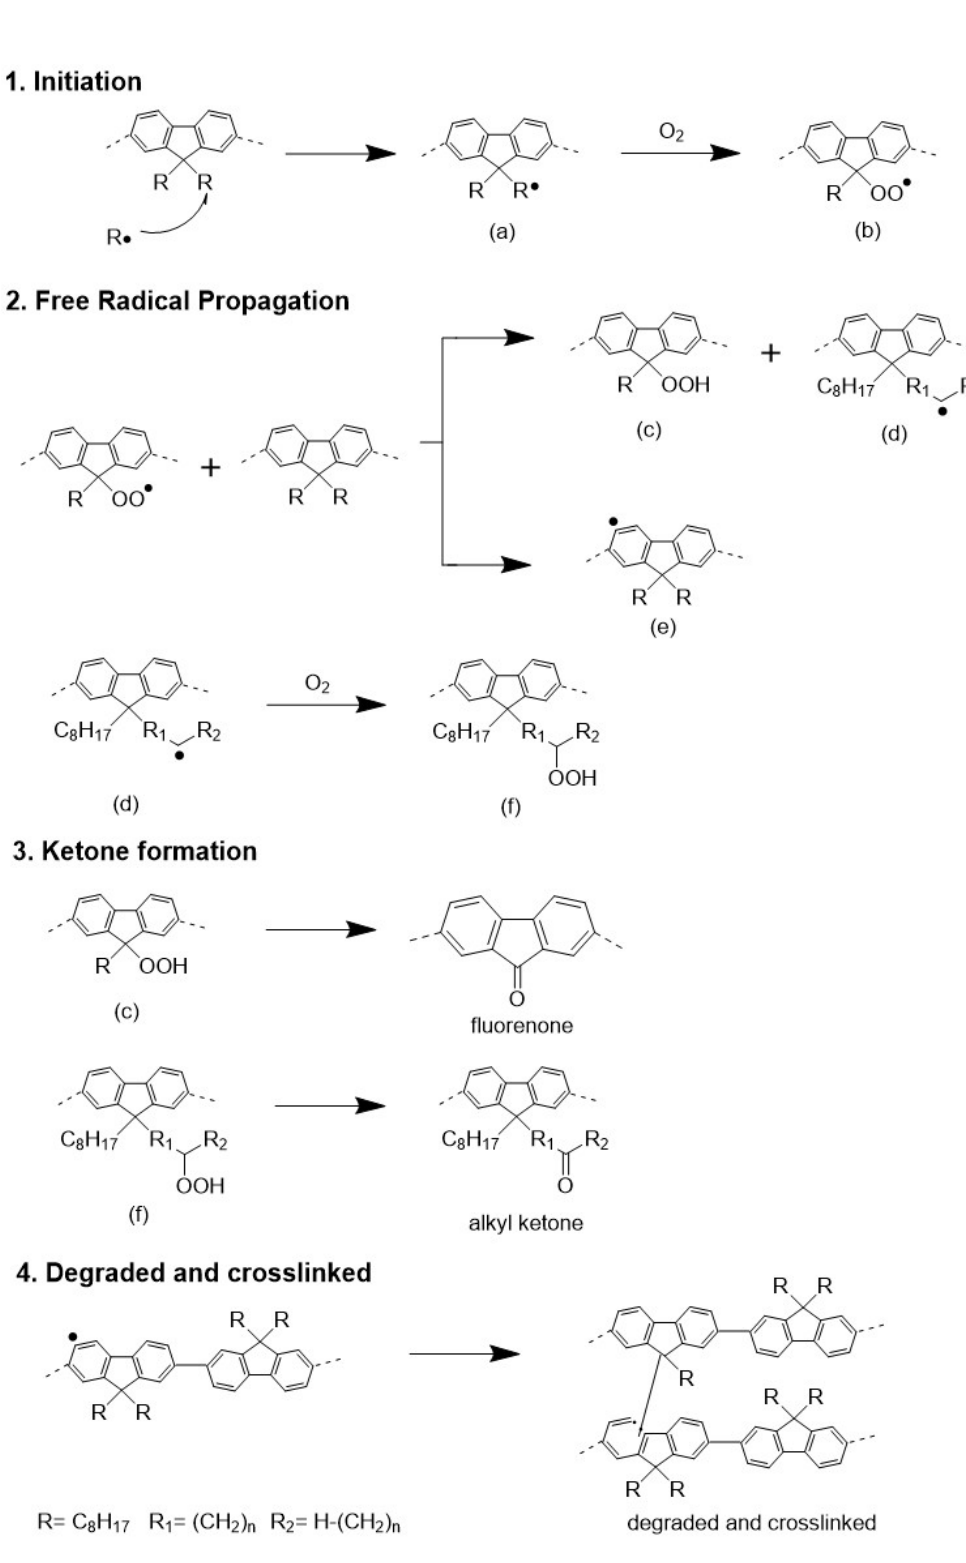
Figure 9. Thermal oxidation degradation pathway for aggregated PFO films.